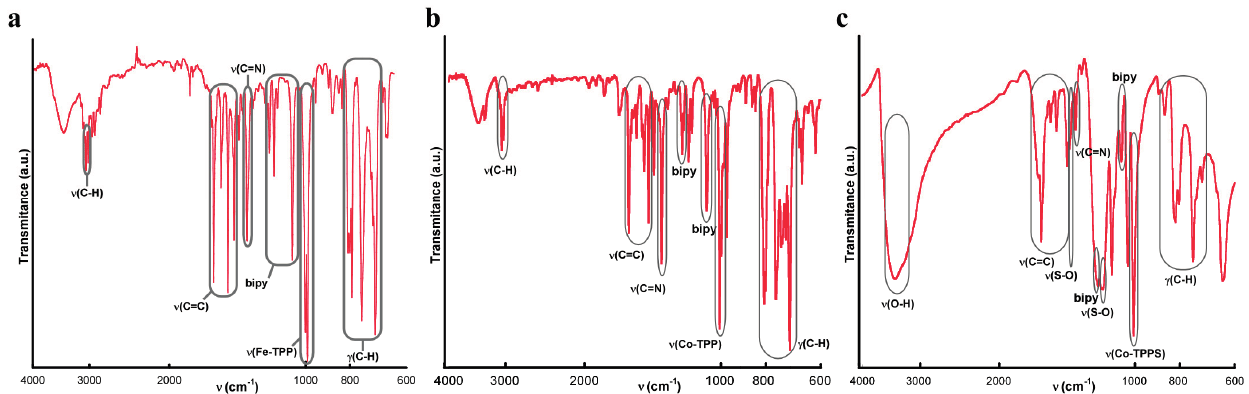
Figure 10. IR spectra for compounds ( a ) 3 ; ( b ) 4 and ( c ) 5